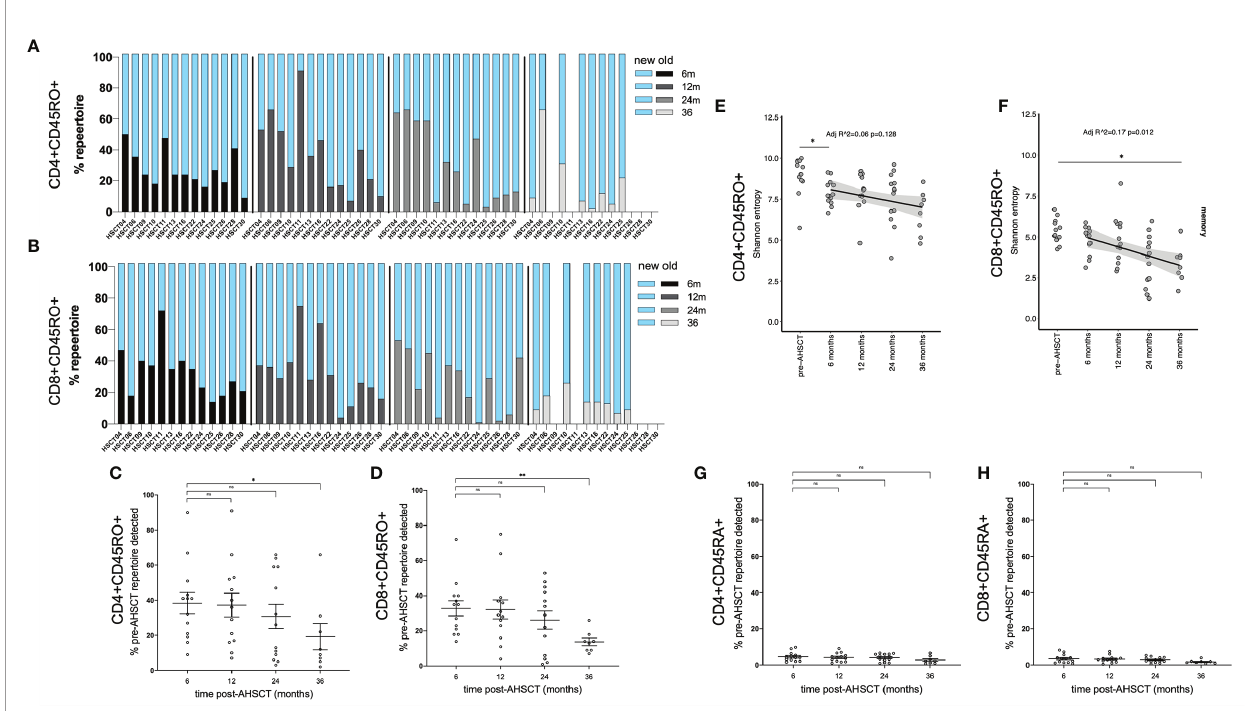
FIGURE 2 | Kinetics of CD4+ and CD8+ memory clones following AHSCT. The proportion of the TCR repertoire that was new (blue) compared to baseline (pre- AHSCT) at 6, 12, 24 and 36 months and persistent (also detected pre-AHSCT) at 6 (black), 12 (dark grey), 24 (light grey) and 36 (silver) months for each individual is depicted in the CD4+CD45RO+ repertoire (A) and CD8+CD45RO+ repertoire (B) . Mean clonal persistence of the top 100 clones pre-transplant in the (C) CD4 +CD45RO+ population and (D) CD8+CD45RO+ population at 6, 12, 24 and 36 months post-AHSCT. A progressive decline in the persistence of the dominant clones is observed. Diversity in (E) CD4+CD45RO+ and (F) CD8+CD45RO+ populations in the months following AHSCT. A signi fi cant downward trend, and drop between pre-AHSCT and 36 months was seen in entropy scores of CD8+CD45RO+ population post AHSCT. In the CD4+CD45RO+ population a signi fi cant drop in diversity occurs in the fi rst 6 months, then values were not signi fi cantly different to pre-AHSCT. Mean clonal persistence of the dominant clones pre-transplant in the (G) CD4+CD45RA+ population and (H) CD8+CD45RA+ population at 6, 12, 24 and 36 months post-AHSCT. Bar/error bars in (A, B) show mean +/- SEM. Mann- Whitney t-tests were conducted with a Bonferroni correction applied, resulting in a signi fi cance level set at p < 0.025. *p < 0.025, **p <